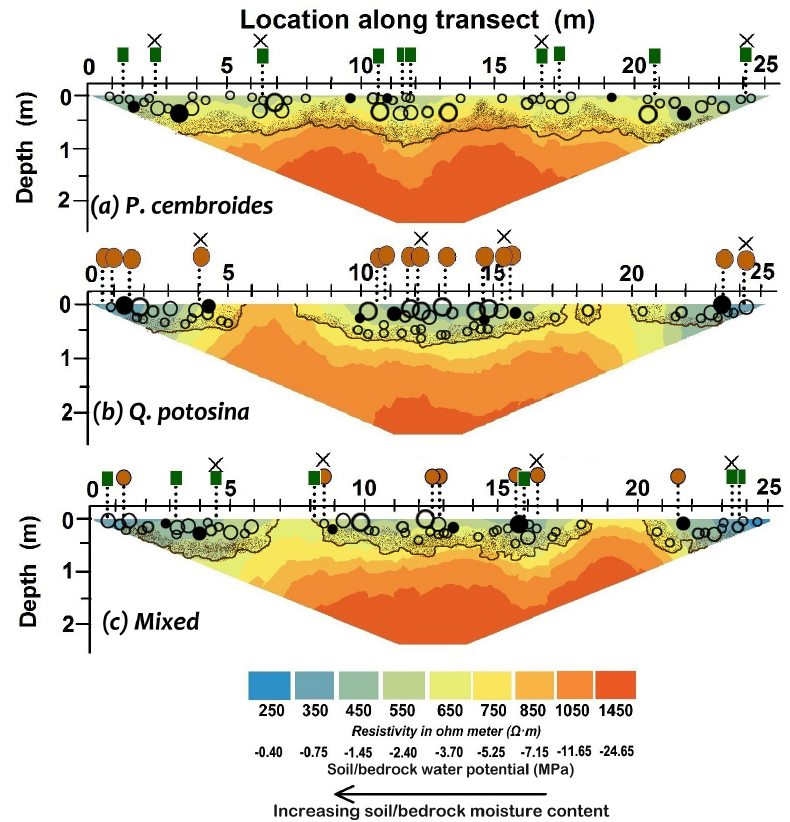
Figure 5. ETR tomograms in (a) Pinus cembroides , (b) Quercus potosina and (c) pine–oak forest stands. ERT profiles showed a relationship between the position of roots, low soil resistivity (greater water availability) and greater bedrock fracturing. The top soil corresponds to the first 20–25cm layer, the intermediate layer includes soil pockets and rock fractures and is depicted by the dotted strip along the radargram and the fresh bedrock begins underneath the solid line. Circles of different size depict roots of different diameter size (see figure legend in Fig. S4). Black circles indicate roots that were used for GPR calibration. Trees marked with X indicate the presence of soil psychrometer